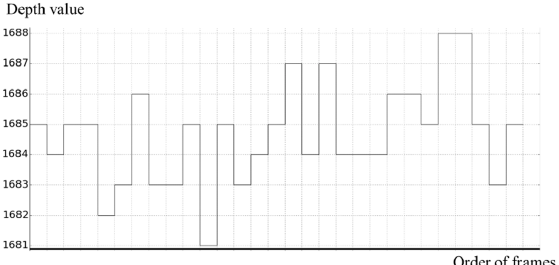
Figure 1. Noises according to frame flow for one depth pixel in depth picture.